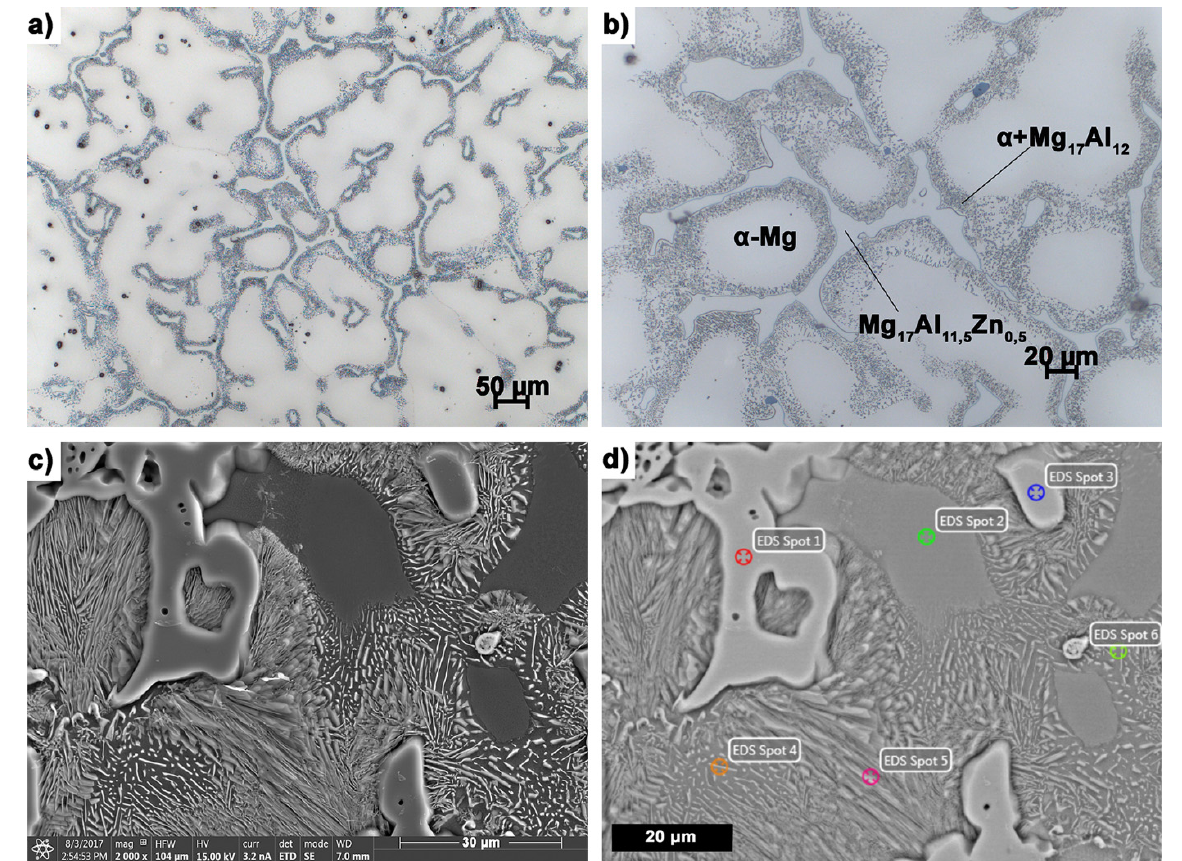
Figure 2. Microstructure of AZ91 (MgAl9Zn1) sand casting magnesium alloy recorded with ( a , b ) optical microscope, ( c , d ) SEM.